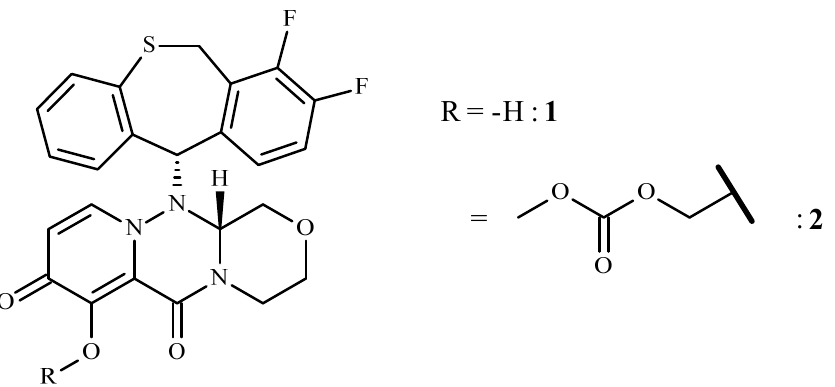
Figure 1. Structures of baloxavir ( 1 ) and its prodrug baloxavir marboxil ( 2 ).